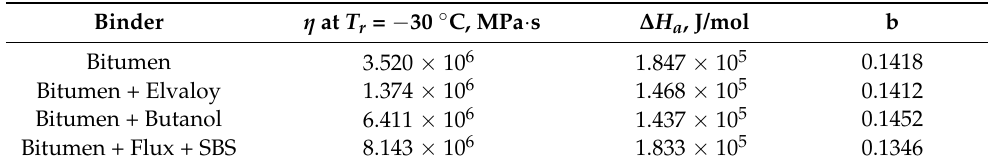
Table 2. Values of the parameters for